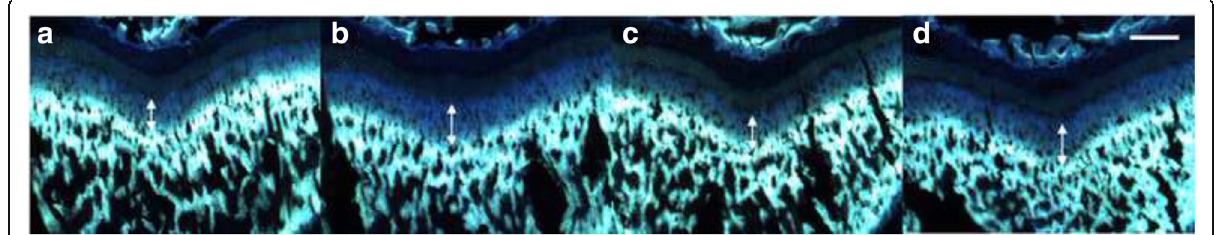
Fig. 2 Fluorescent photomicrographs of longitudinal sections of the proximal tibia in the growth plate. a Control group (distilled water), b recombinant human growth hormone (rhGH) group (20 μ g/kg), c 100 mg/kg YJT group, and d 300 mg/kg YJT group. The fluorescent line corresponds to the injection of tetracycline, which binds with calcium and can be detected with ultraviolet illumination. The arrow between the fluorescent line formed by the tetracycline and the epiphyseal end line of the growth plate indicates the extent of bone growth during the 48 h study period. Scale bar=200 μ m